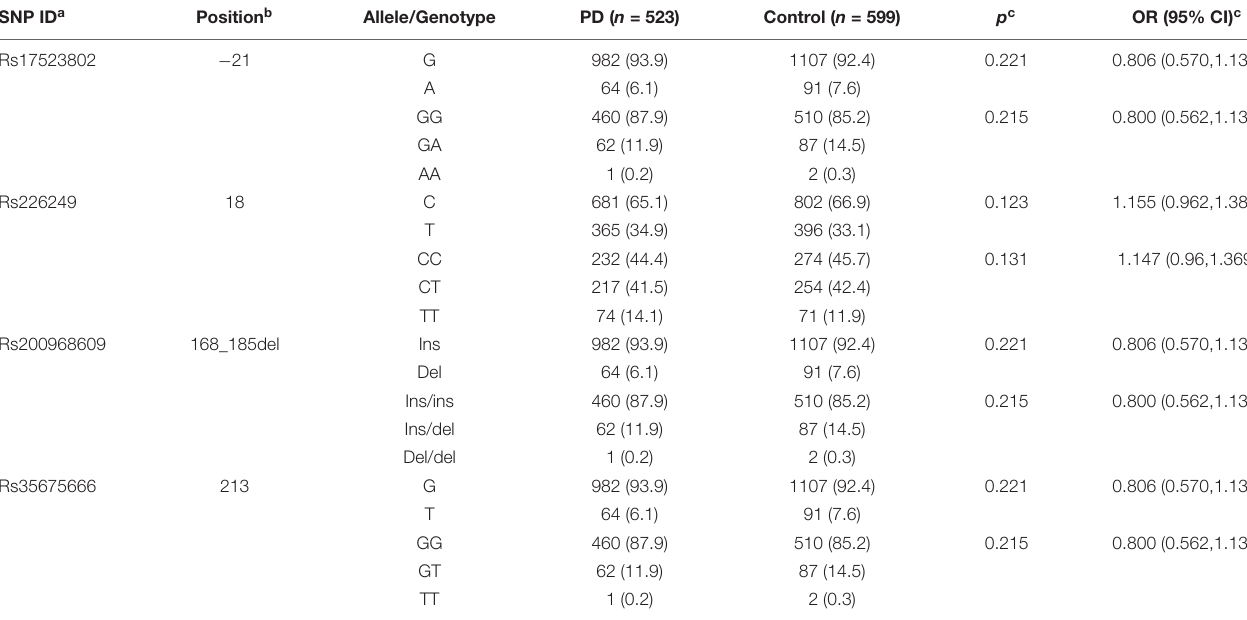
TABLE 2 | Genotype and allele distribution between total PD patients and controls of polymorphisms in DJ-1 promoter